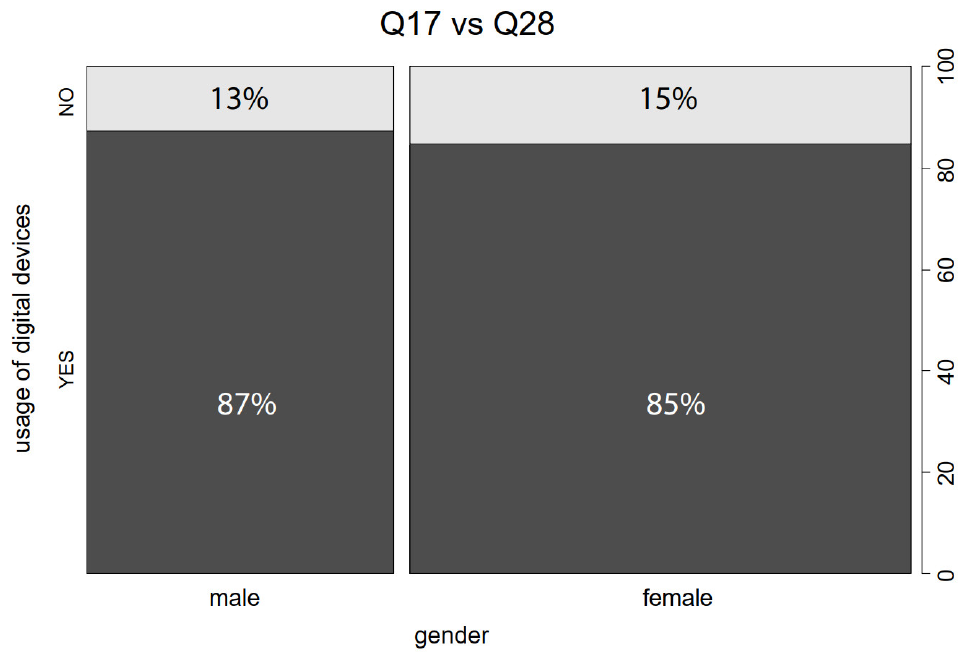
Figure 9. The distribution of answers for Q17 (usage of digital devices) and Q28 (gender).